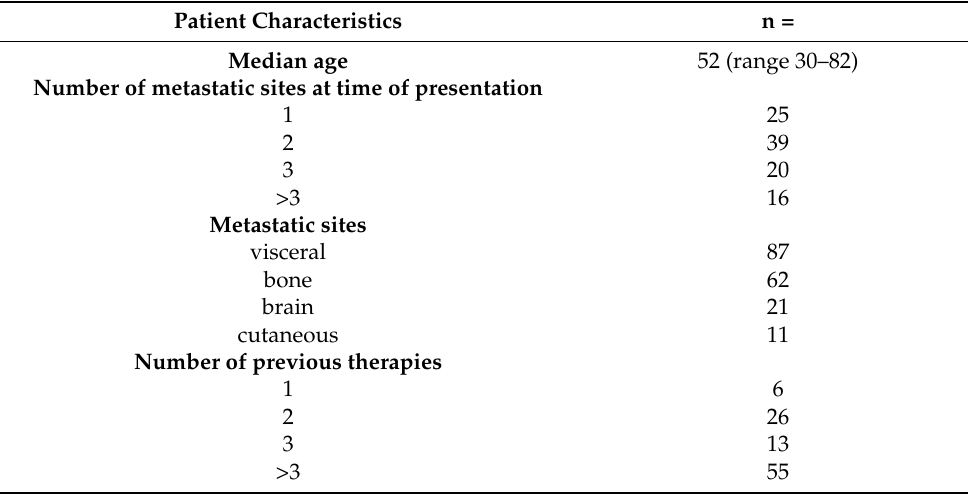
Table 3. Patient characteristics (n = 100)